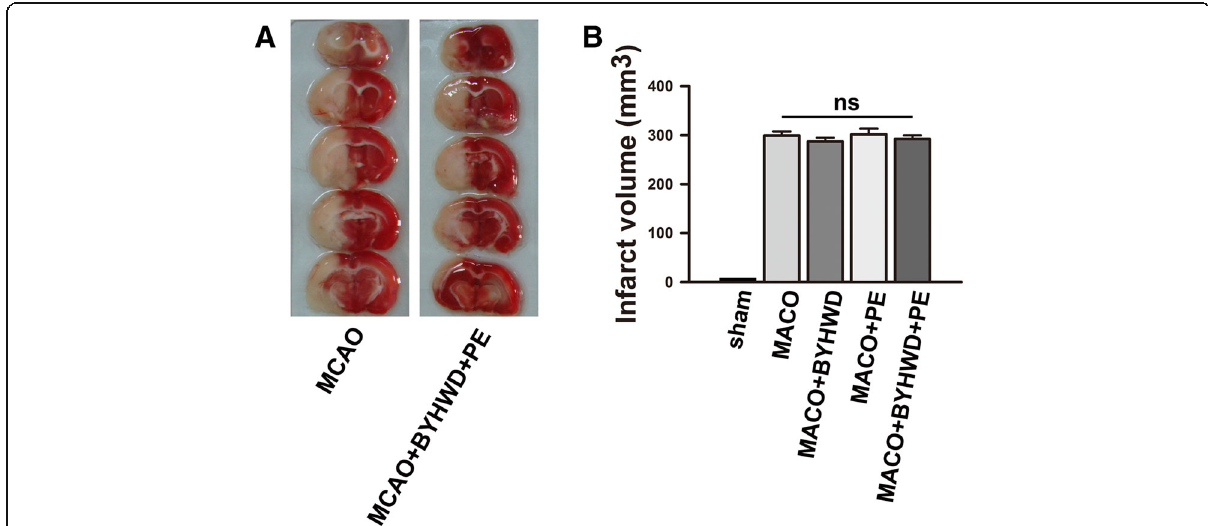
Fig. 3 Representative TTC-stained slices and the infarct volumes in all groups. Representative TTC-stained slices of the coronal brain sections ( a ) from all groups exhibit the pale infarct area induced by a permanent MCAO. The infarct volumes in all groups on Day 3 after the MCAO induction ( n = 5) ( b ). The bars indicate the means ± the standard errors of the means; ns, p > 0.05; *, p < 0.05, relative to the MCAO